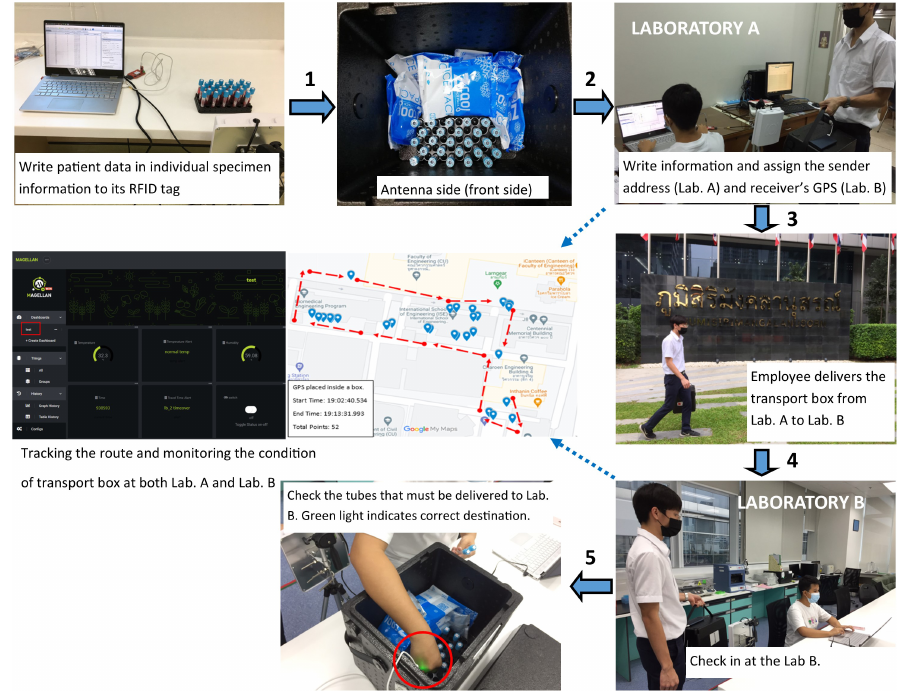
Figure 8. The pilot test of our smart specimen transport system.